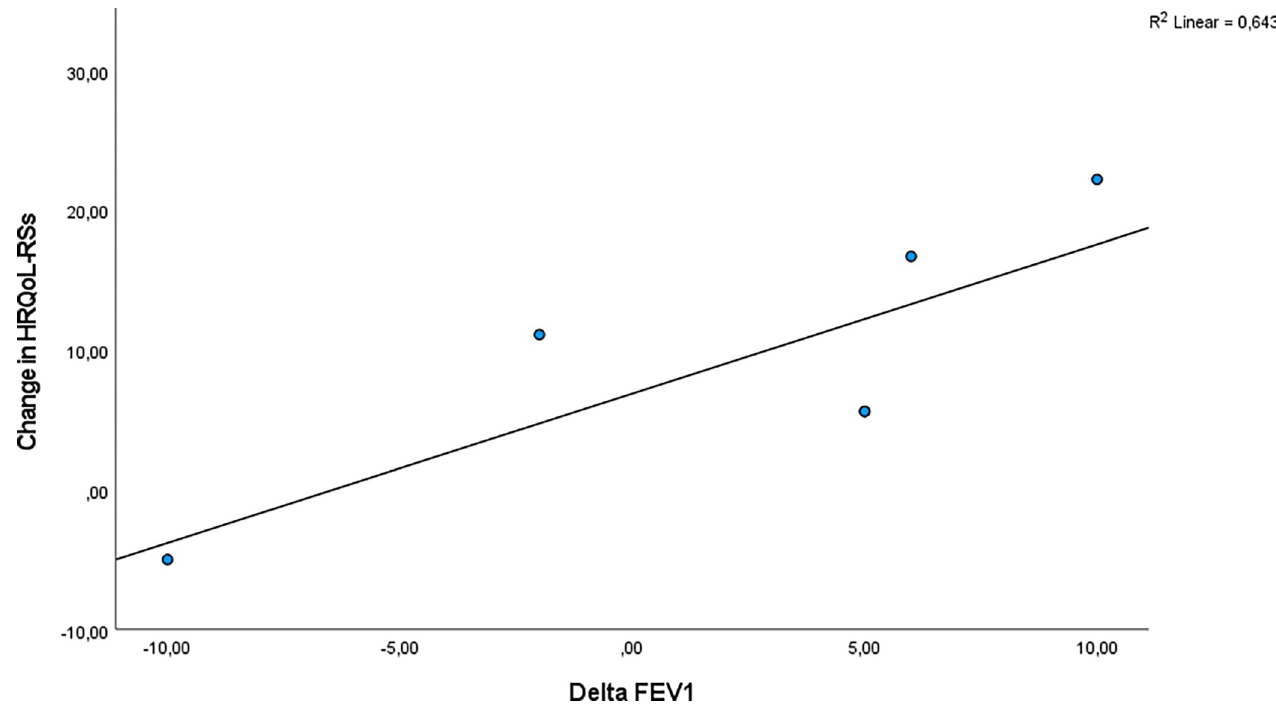
Fig 3. The correlation between change in FEV 1 (start and end of study) and the change in CFQ-R-RSS (start and end of